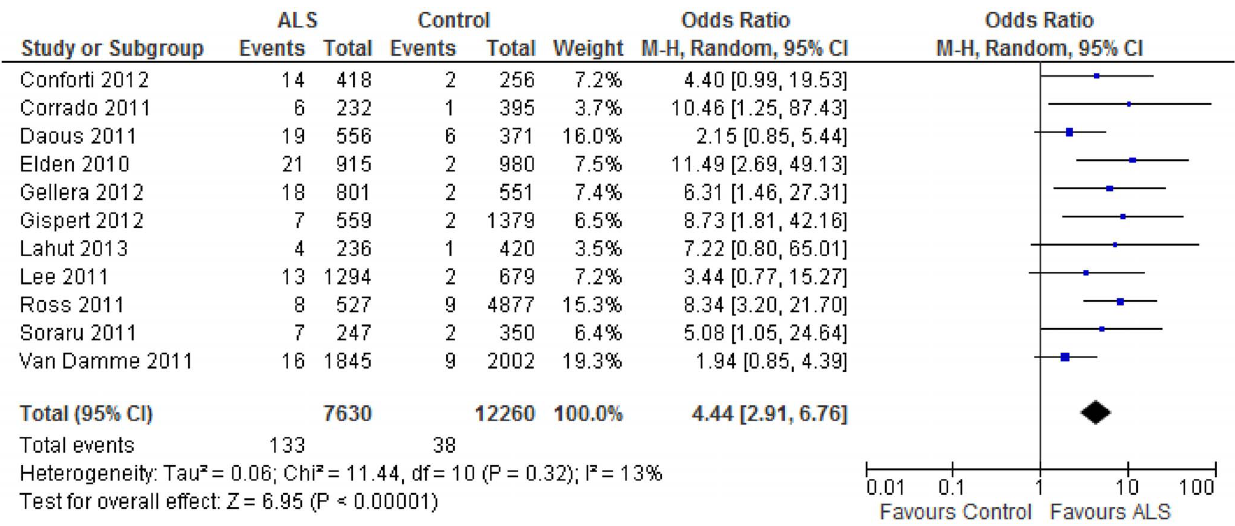
Figure 4. The heterogeneity among included studies was reduced dramatically after excluding two studies from China. This meta- analysis was conducted using same protocol as in Figure 3 except excluding two studies with patients with Chinese background. Please refer to Figure 3.